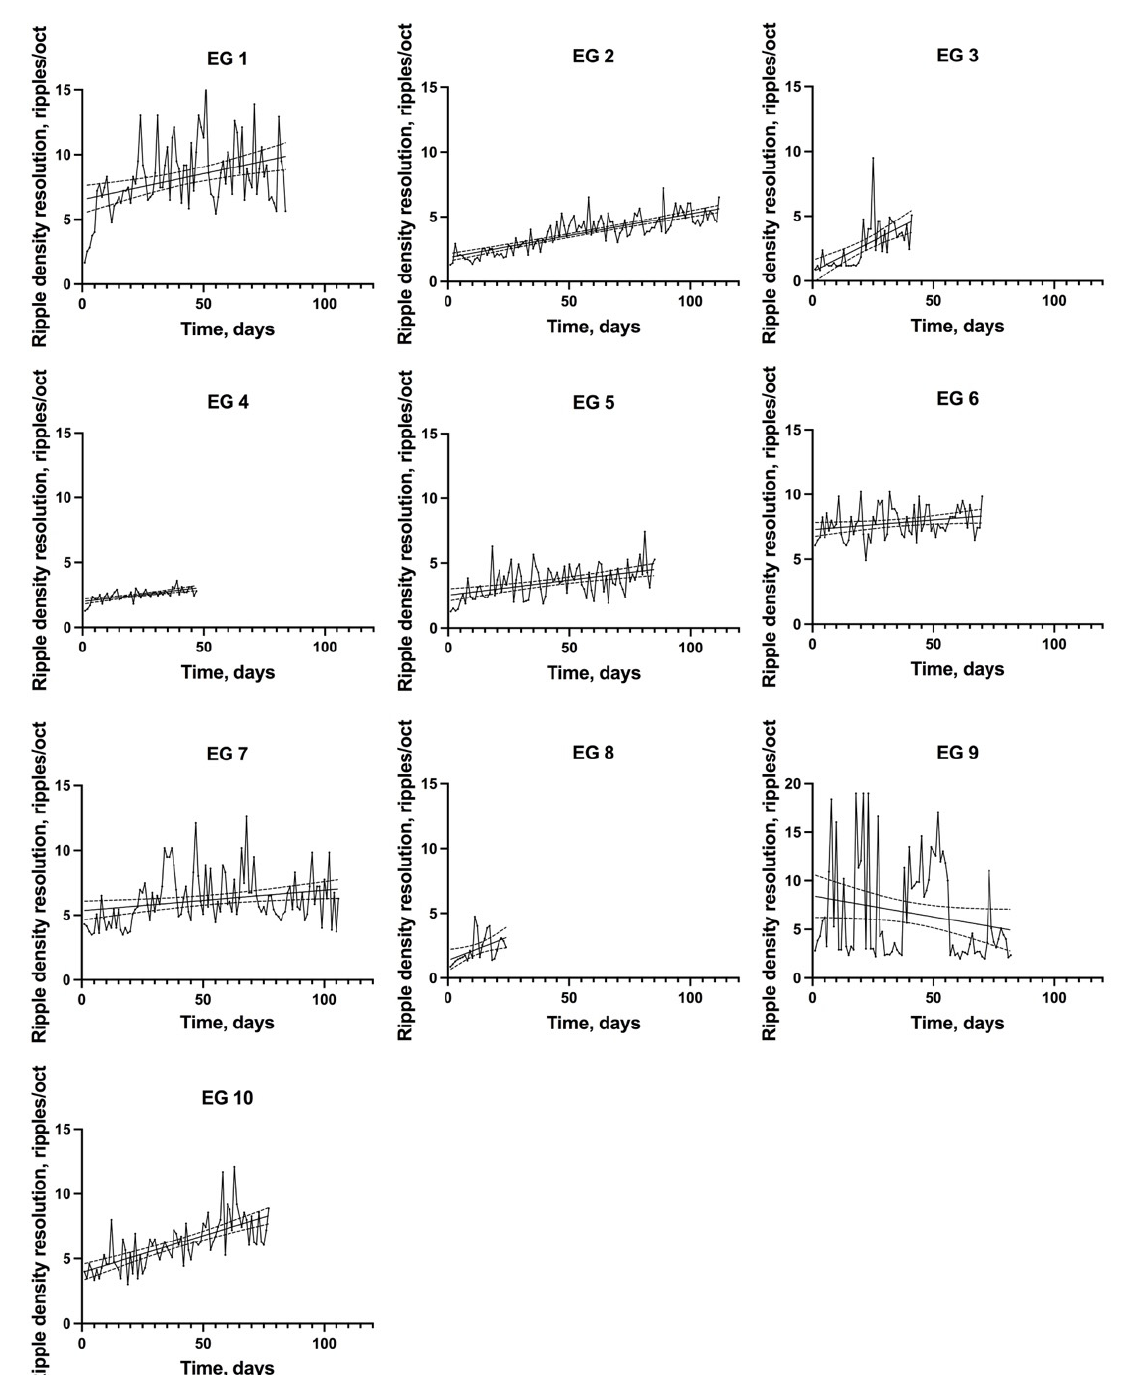
Figure 2. The individual changes of ripple density resolution (ripples/oct) during training. The straight line is a regression line; the dotted lines show 95% confidence bands of the best-fit line. The results of the word recognition test showed that the percentage of recognized words increased after training in 9 out of 10 EG CI users (Table 3, Figure 3). The Wilcoxon matched-pairs test showed a significant difference between the percentages of recognized words before training and after training ( p = 0.0039, N = 10, W = 45). In the CG, the Wilcoxon matched-pairs test did not reveal a significant difference between the percentage of recognized words for the test and retest ( p > 0.9, N = 5, W =